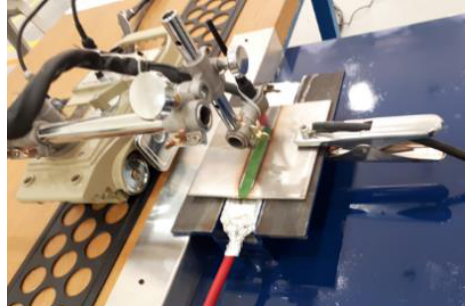
Figure 2. Experimental machine of TIG welding with flux paste: a motorized carriage, torch and workpiece. Table 2. Welding parameters.